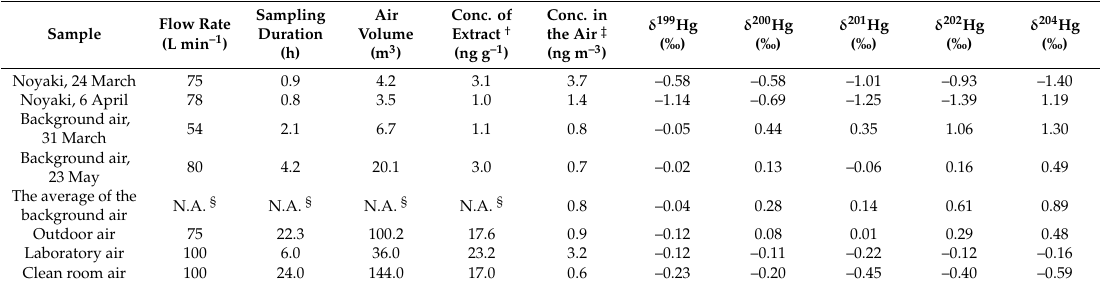
Table 4. Results of the overall methodology tests.